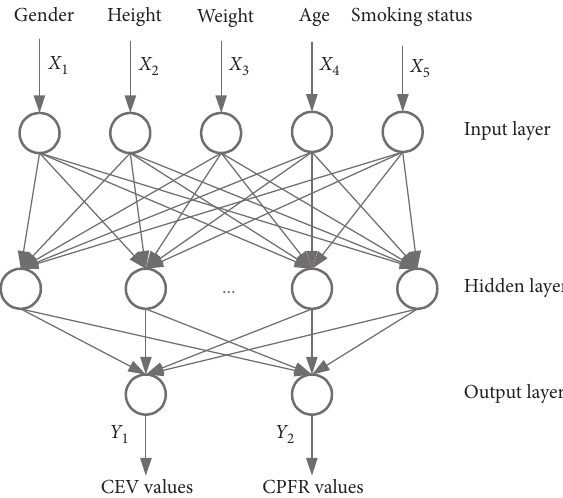
Figure 2: The BP neural network structure used in this study. A three-layer structure was adopted. There are five neurons in the input layer, eleven neurons in the hidden layer, and two neurons in the output